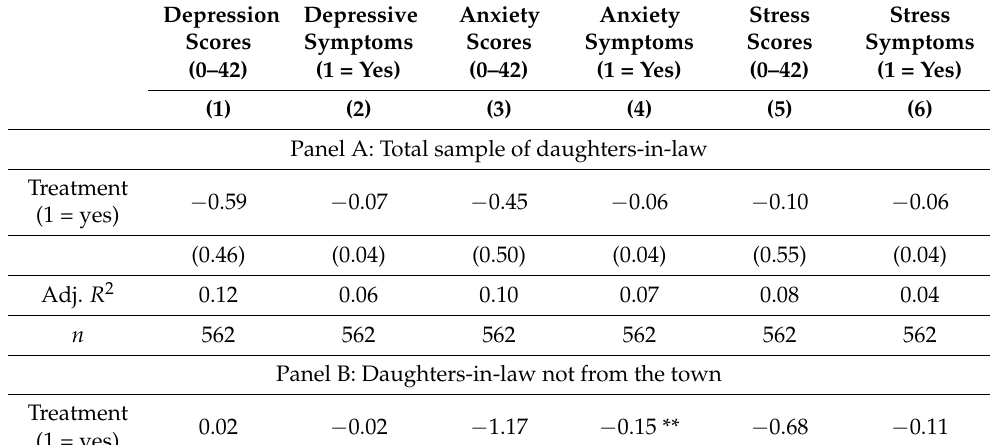
Panel B: Daughters-in-law not from the town